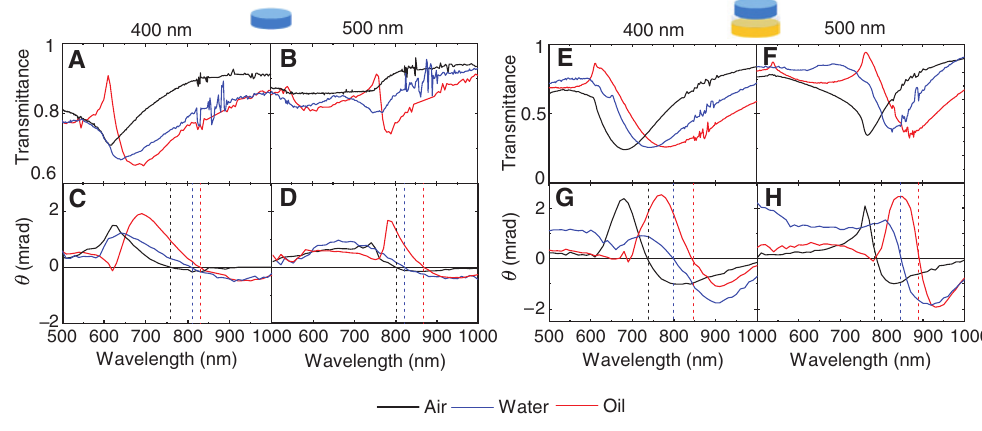
Figure 3: Optical and magneto-optical spectra of nanoparticle arrays. (A, B, E, F) Transmittance and (C, D, G, H) Faraday rotation of periodic arrays of Ni nanoparticles (left panels) and periodic arrays of Ni/SiO Au dimers (right panels), measured in air (black curves), water (blue curves), and index matching oil (red curves). Data for a lattice para- meter of a = 400 nm and a = 500 nm are shown. The dashed vertical lines in the lower panels indicate the Faraday rotation nulling condition for the different dielectric environments.